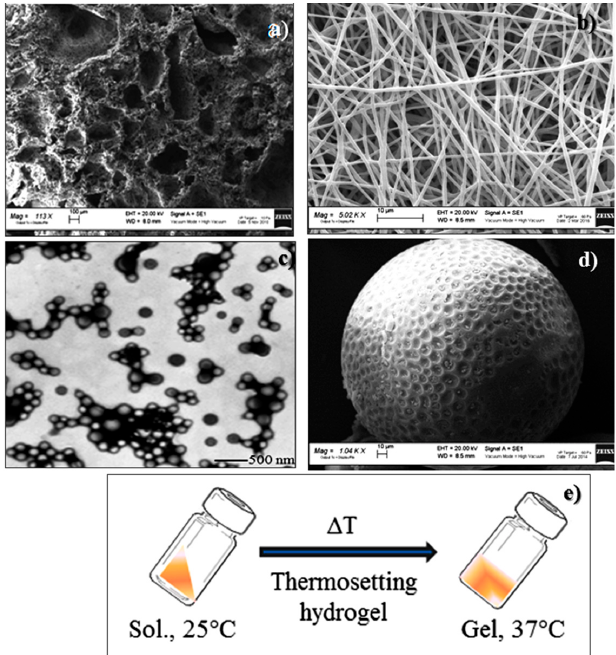
Figure 1. Examples of polymeric scaffolds for tissue regeneration/drug delivery: ( a ) 3D-porous matrix; ( b ) nanofibrous matrix; ( c ) nanoparticles; ( d ) microspheres; ( e ) thermosensitive hydrogel.